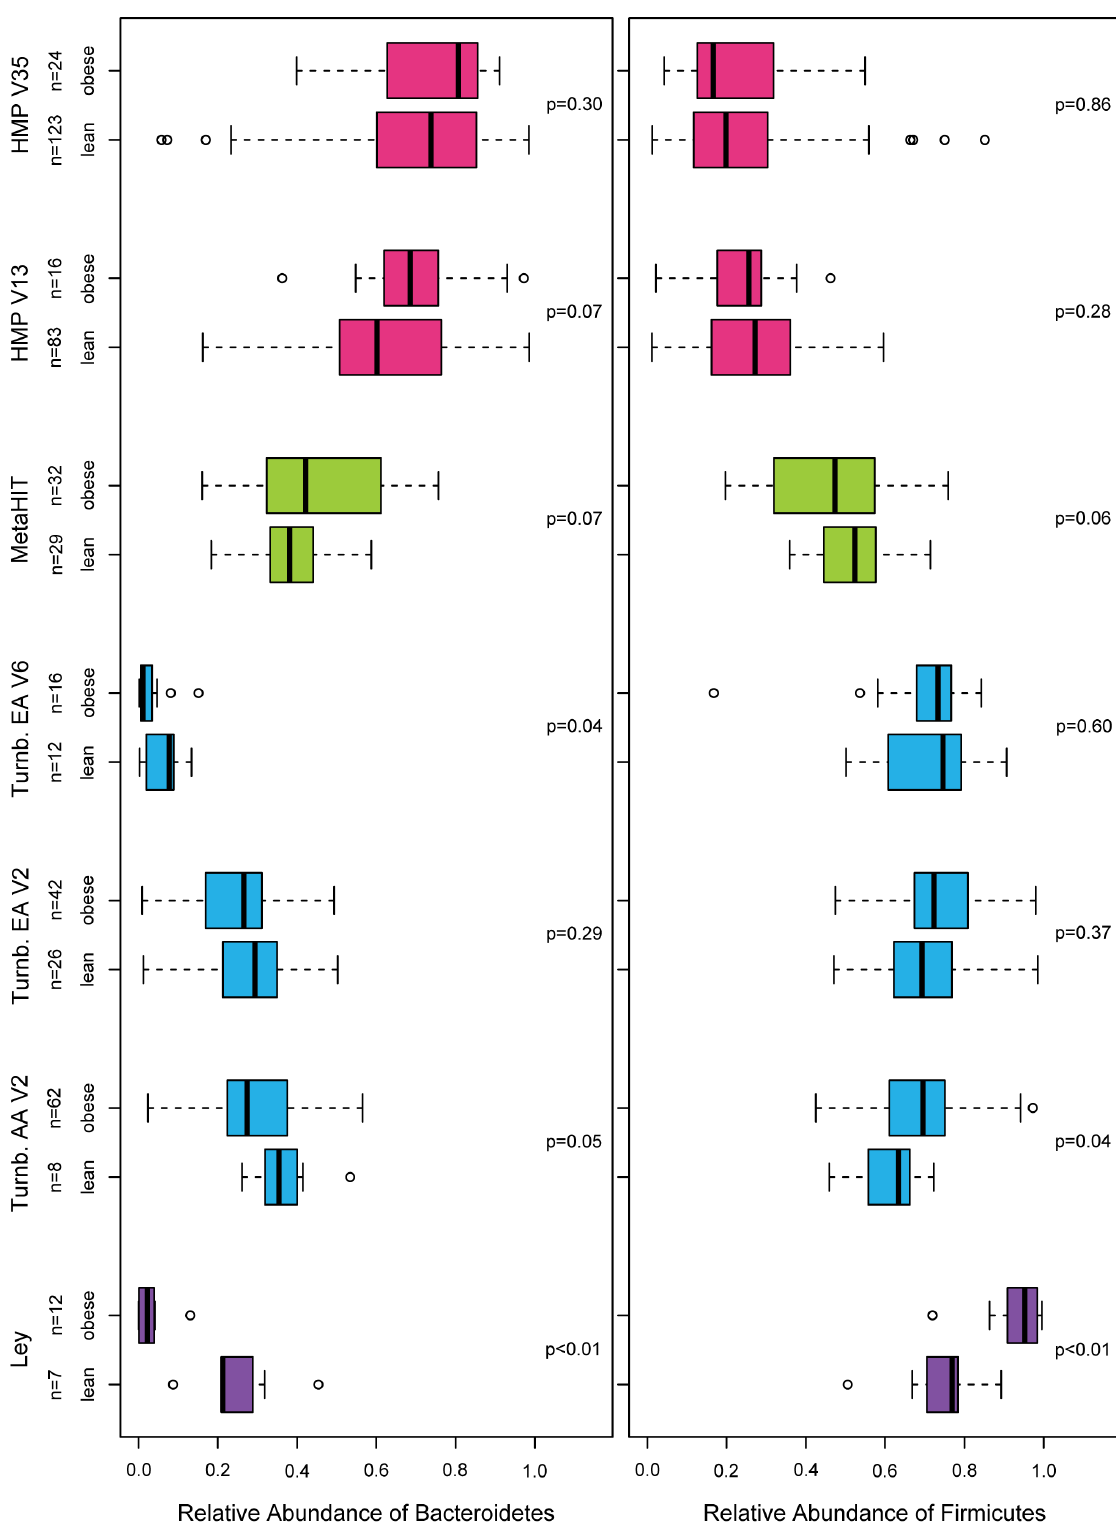
Figure 3. The between-study variability in the relative abundance of Bacteroidetes and Firmicutes is greater than the within-study differences between lean and obese individuals. The Ley data are from [6]. The ‘‘Turnb.’’ data are from Turnbaugh et al. [7], from African Americans (AA) and European Americans (EA), from variable regions (V) 2 and 6. The MetaHIT data are from the Danish subjects in [16] who do not have inflammatory bowel disease. The HMP data are from V13 and V35. We note that the primary results from this manuscript were generated using data from HMP V35. All p-values by t -test.